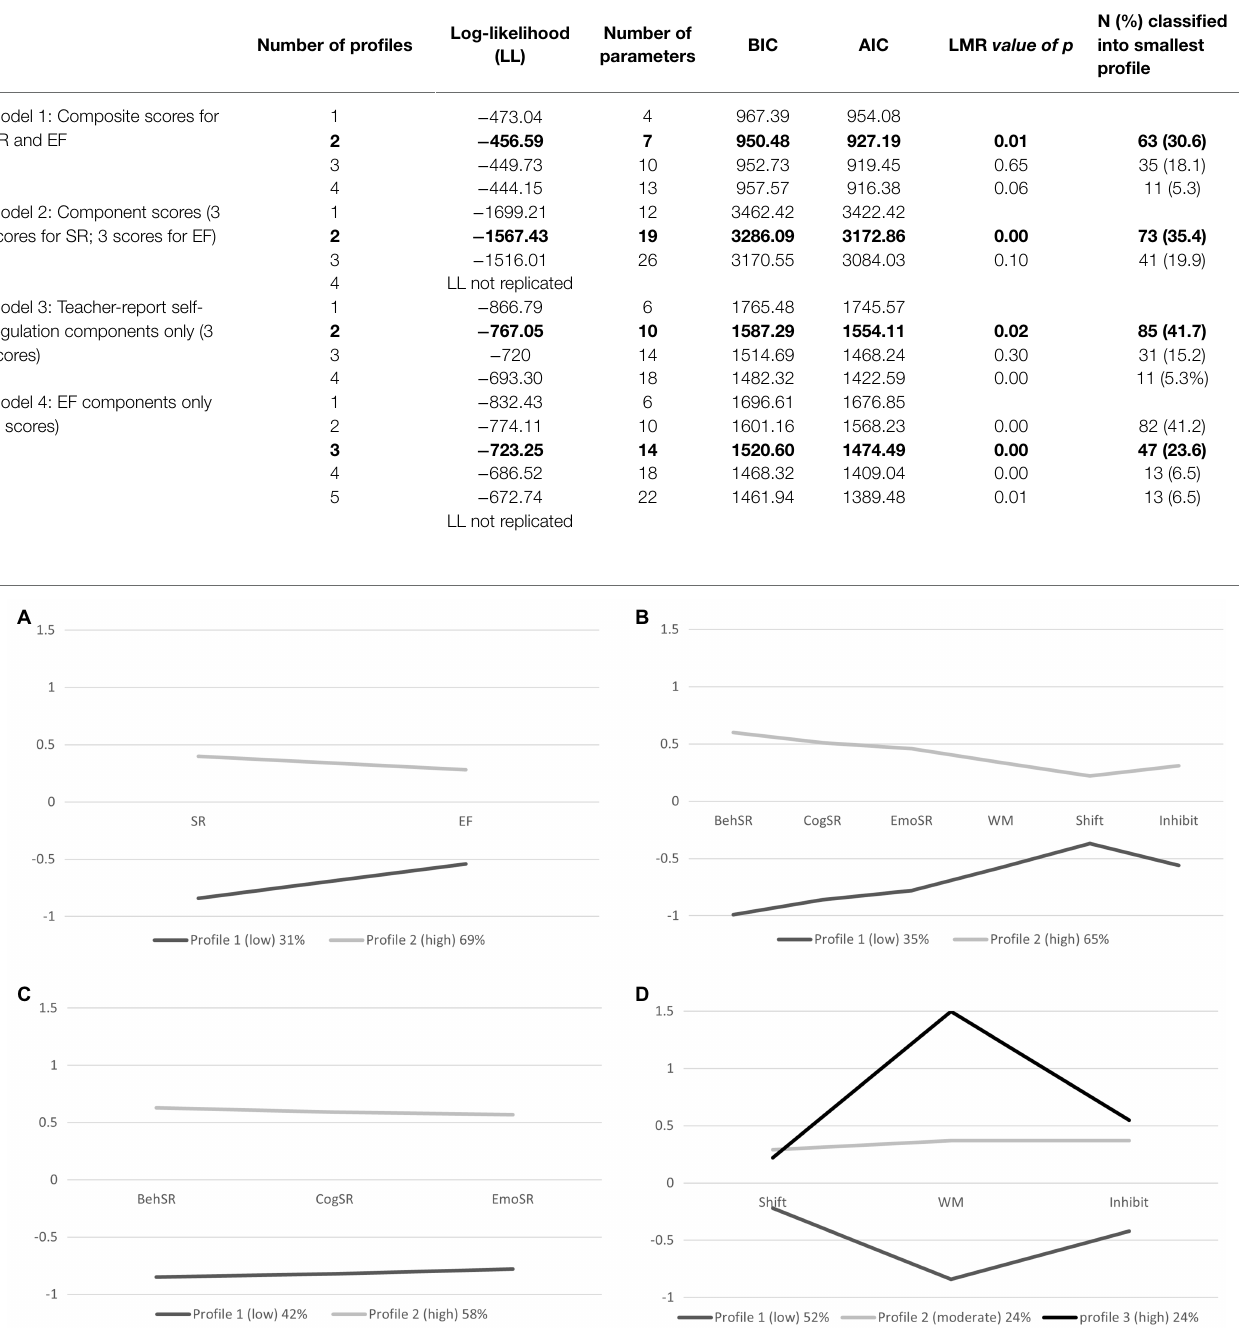
TABLE 2 | Model fit information for the latent profile